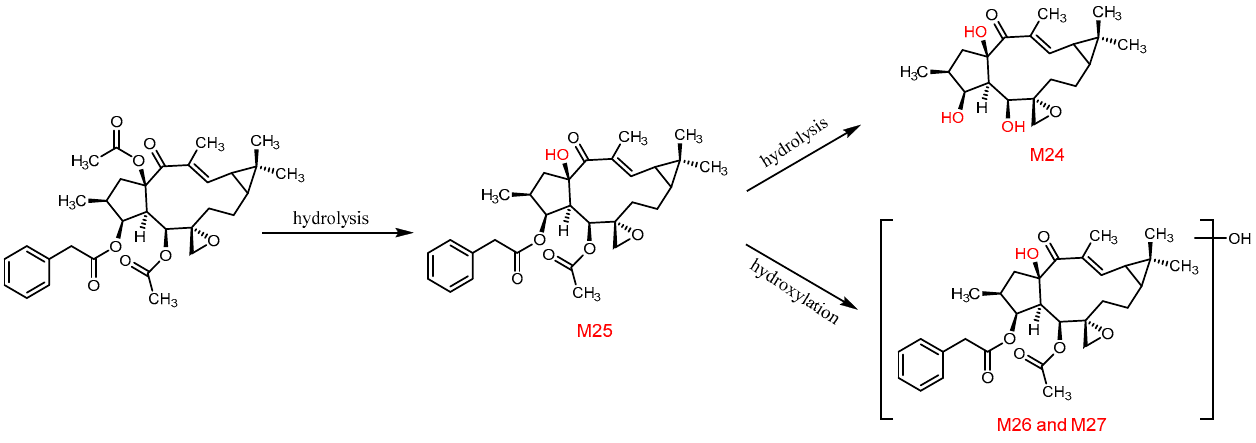
Figure 11. The proposed metabolic pathway of euphorbiasteroid in rats ( Ⅲ ).